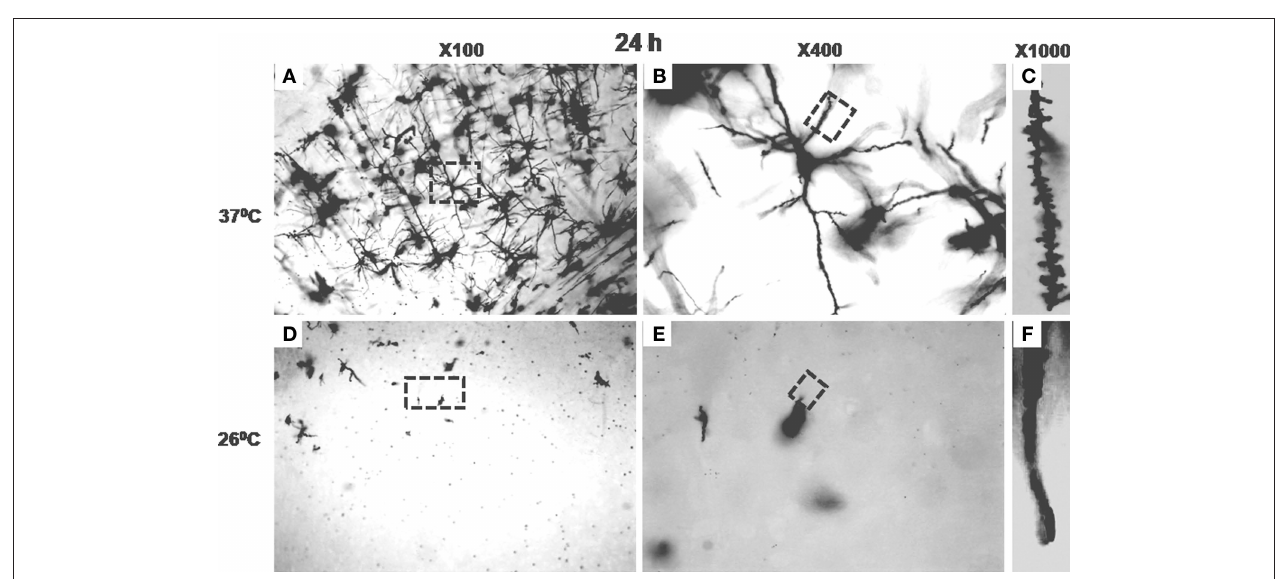
FIGure 6 | Stained neurons or parts in sections from cortical areas of brain blocks incubated at 37 ± 1 ° C for 24 h are shown under various magnification in (A–C) ; while after incubation for 24 h at 26 ± 1 ° C are shown in (D–F). (A) and (D) are at × 100; the areas marked on ( A) and ( D) are shown at × 400 in (B) and (e) , respectively. The areas marked on (B) and (e) have been shown at × 1000 in (C) and (F) , respectively; spines can be clearly seen in (C) but not in (F) .